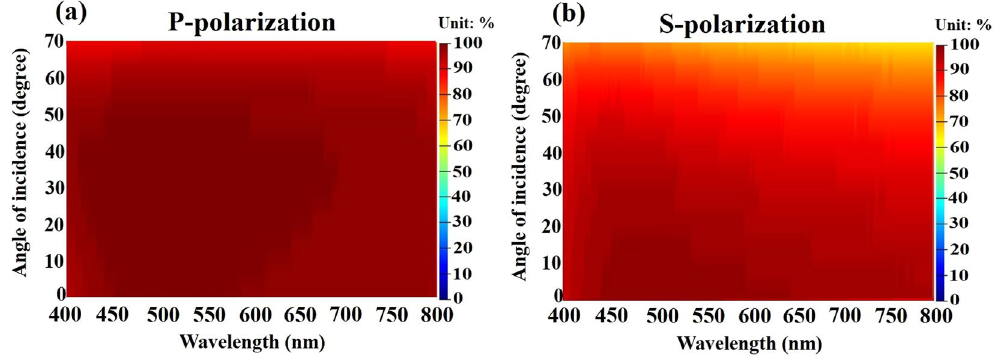
Figure 12. Measured ( a ) p-polarized and ( b ) s-polarized absorptance of seven-layered system as functions of wavelength and angle of